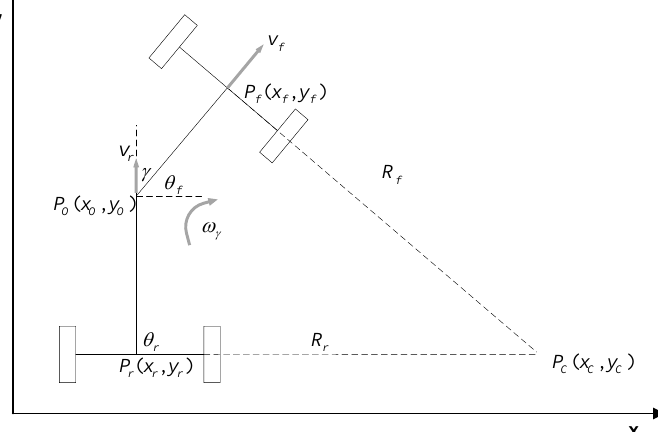
Figure 6. The simplified movement process of the vehicles.